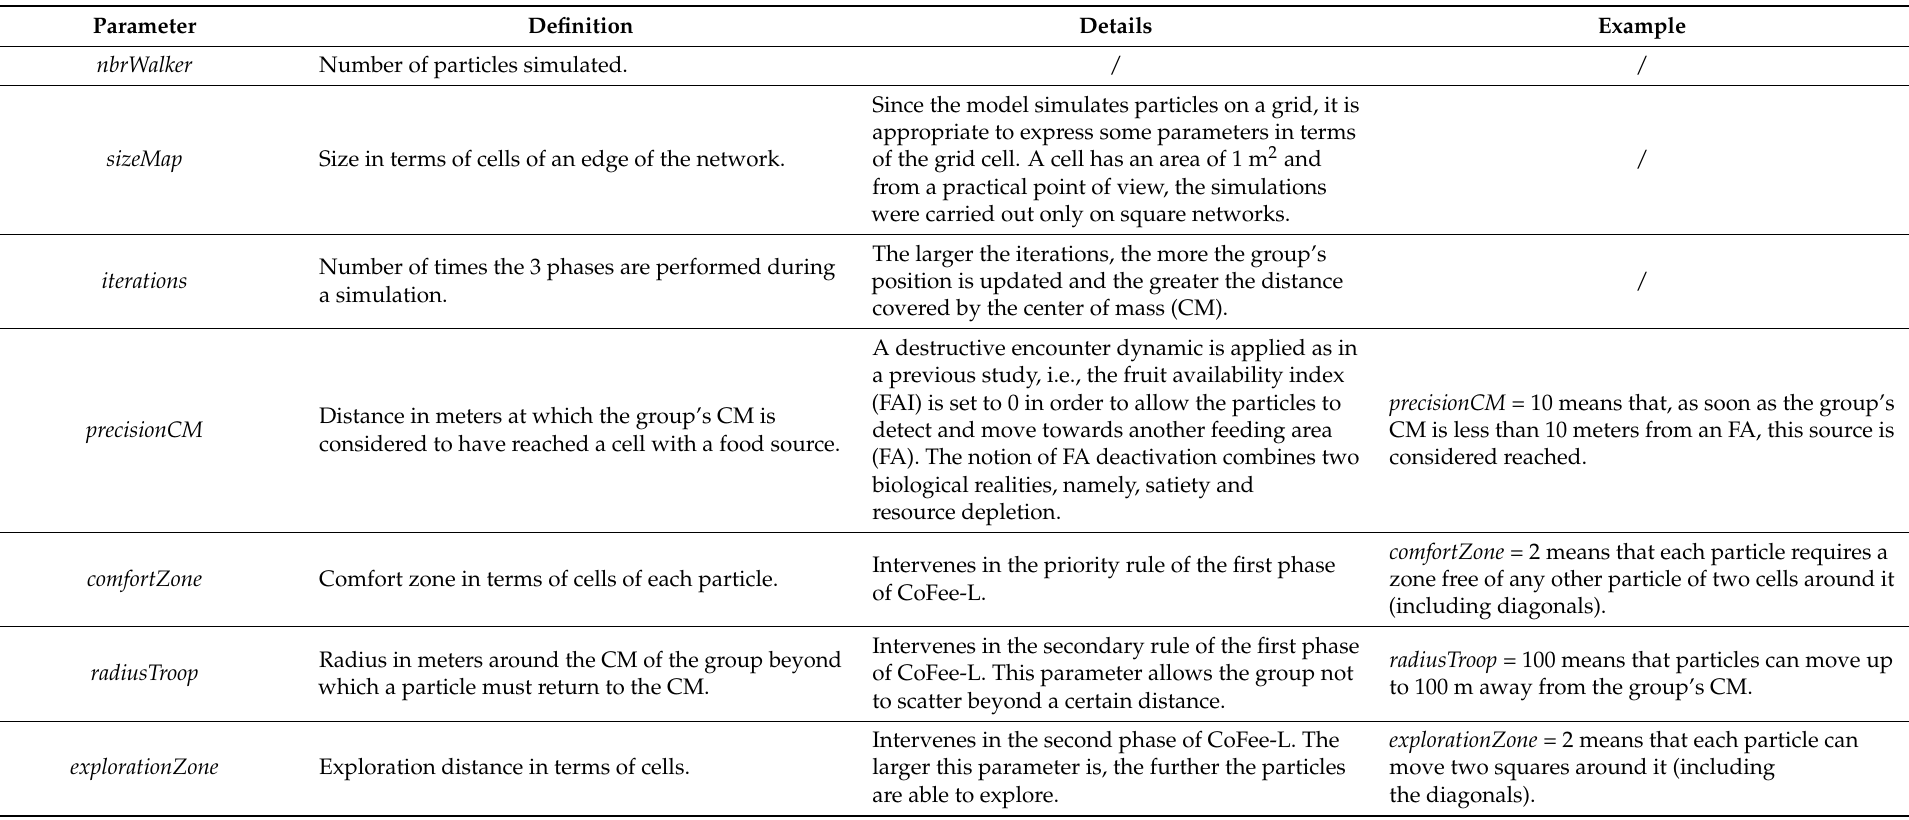
Table 1. Explanation of the 10 parameters governing